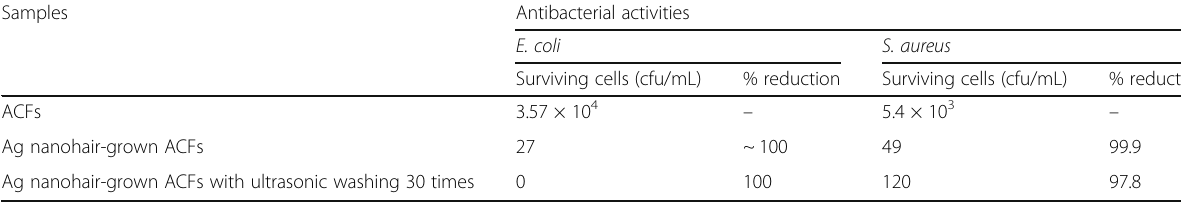
Table 1 Antibacterial activities of ACFs against E. coli and S. aureus